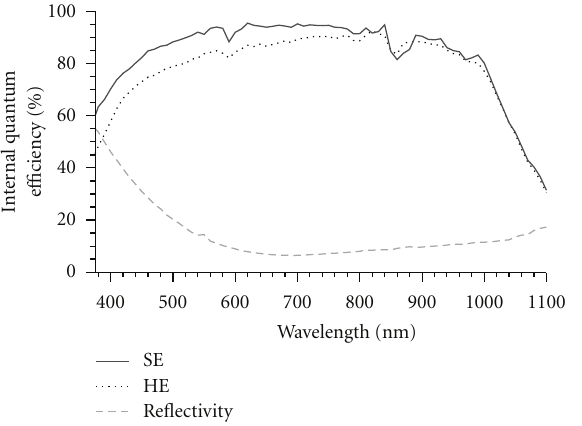
Figure 6: Internal quantum e ffi ciency and